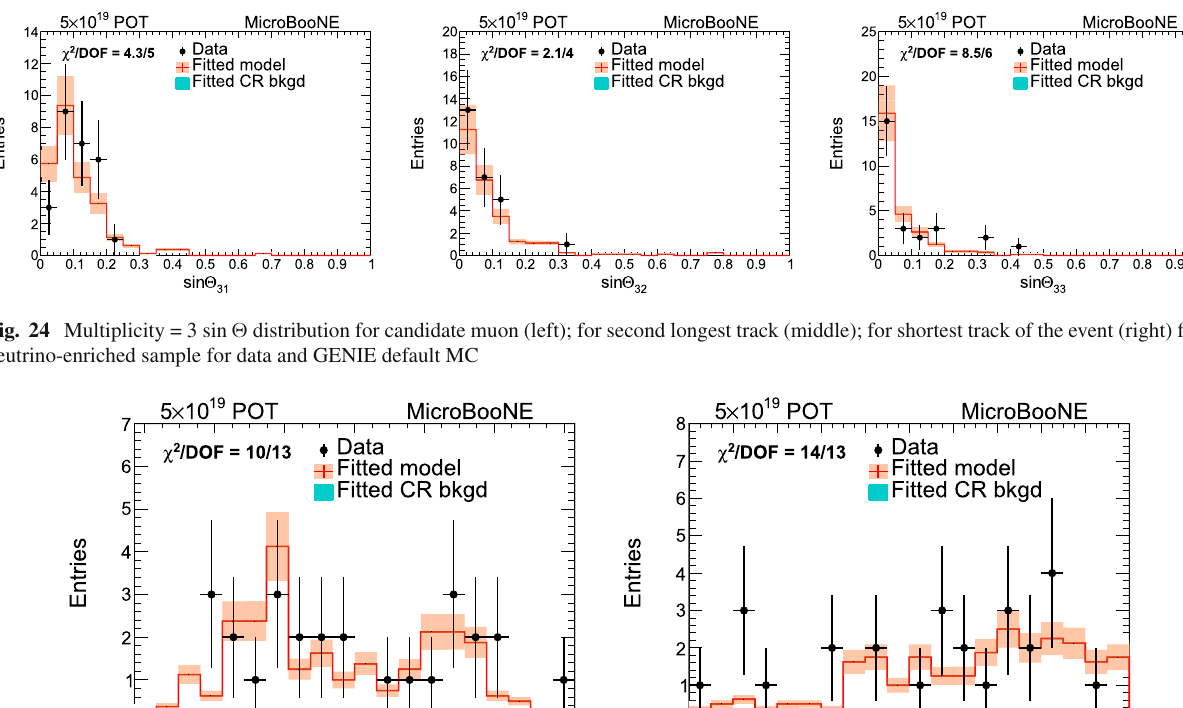
Fig. 23 Multiplicity = 3 cos θ distribution for candidate muon (left); for second longest track (middle); for shortest track of the event (right) from neutrino-enriched sample for data and GENIE default MC